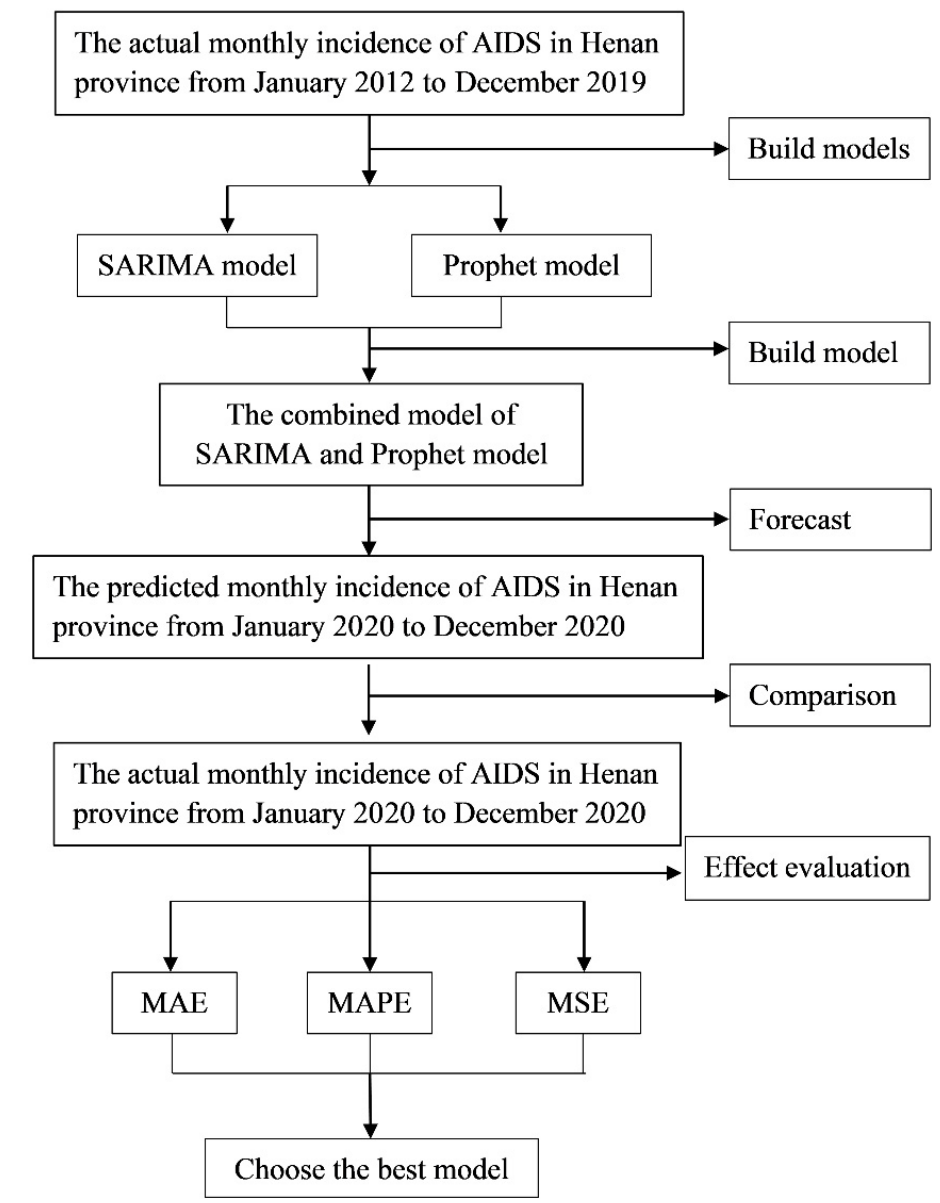
Figure 1. Technical roadmap.